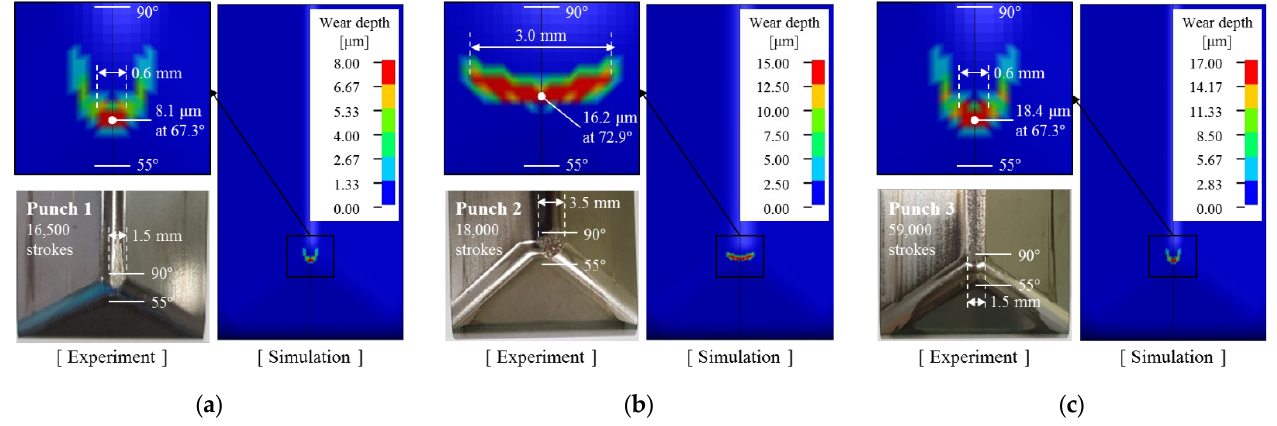
Figure 14. Predicted wear distributions and worn surface conditions on the punch surface after failure: ( a ) Punch 1 with a radius of 3.0 mm coated with PVD CrN, ( b ) Punch 2 with a radius of 5.5 mm coated with PVD CrN, and ( c ) Punch 3 with a radius of 3.0 mm coated with PVD AlTiCrN.